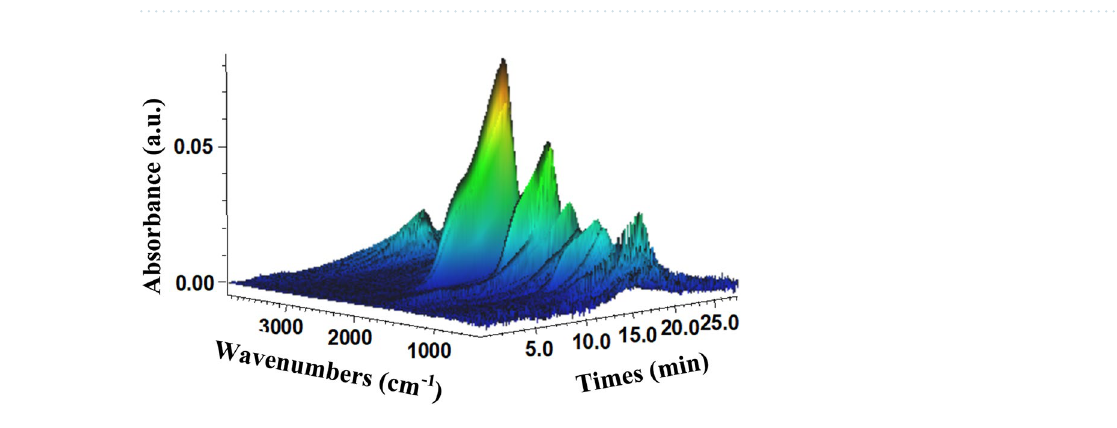
Figure 6. TGA-FTIR of peanut hulls heated to 550